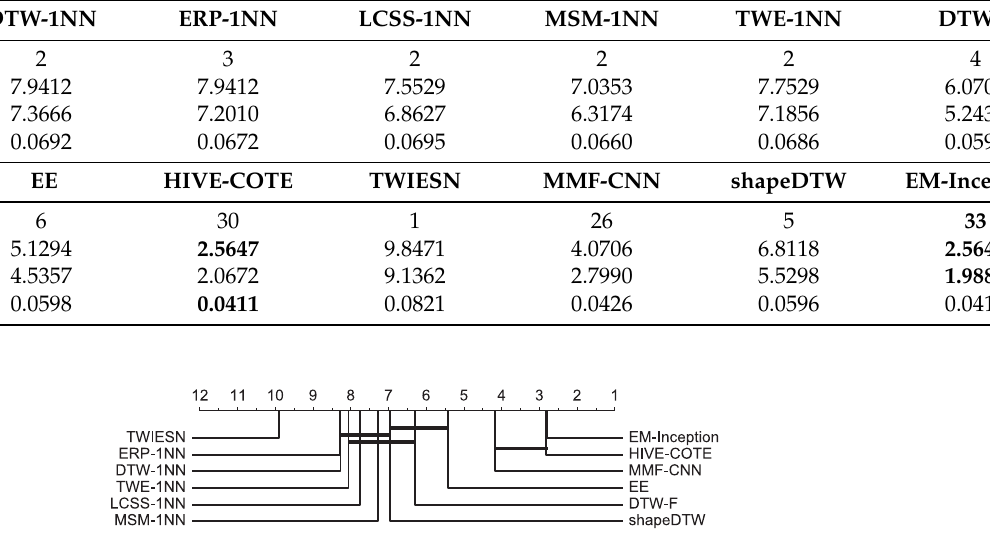
Figure 8. Critical difference diagram of a pairwise statistical difference comparison of 12 methods on the UCR